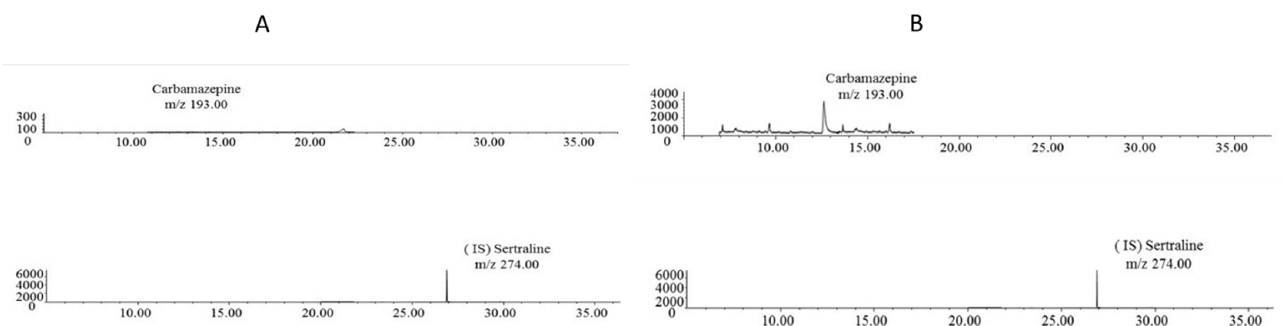
Figure 1. ( A ) Representative chromatograms obtained following the extraction of 0.3 g of drug-free bone pool. ( B ) SIM chromatogram of an extract of 0.3 g of drug-free bone pool spiked with 50 ng of carbamazepine.